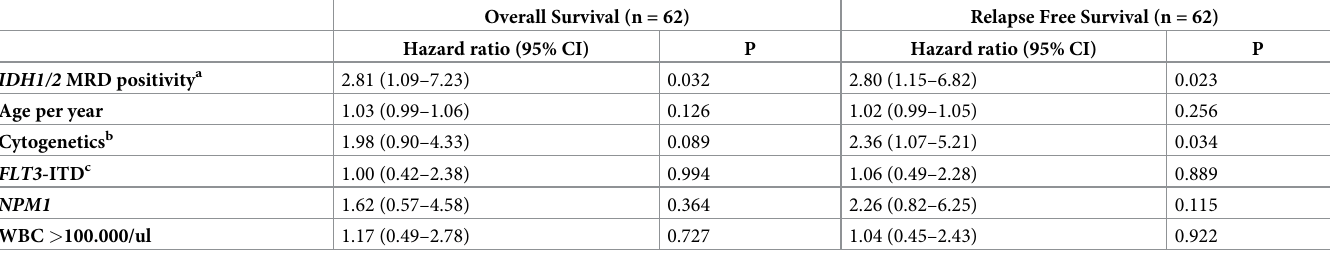
Table 2. Multivariate analysis of IDH1/2 MRD status after